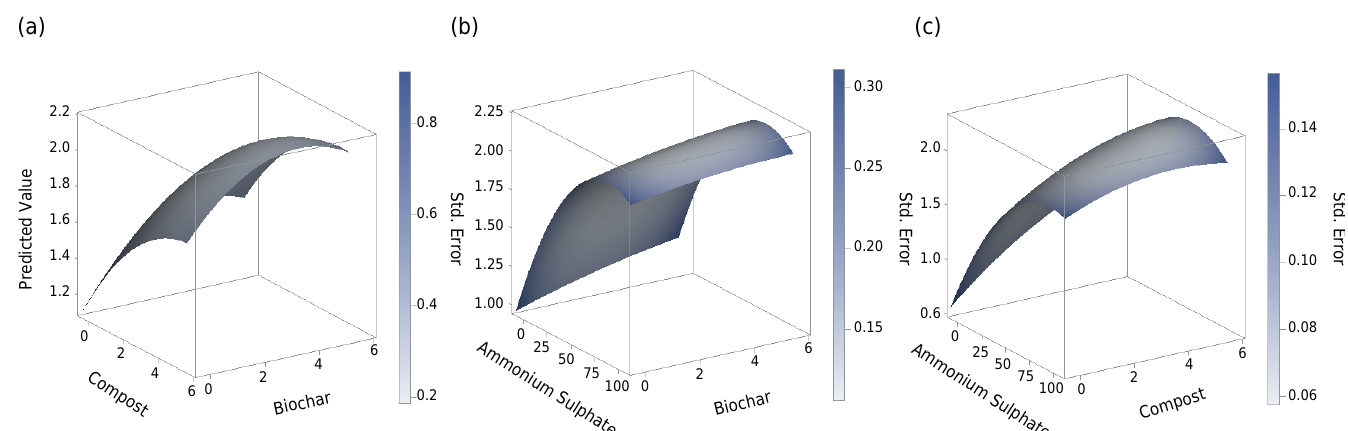
Figure 7. The SY (t ha -1 ) response to independent variable: (a) biochar (t ha -1 ) and compost (t ha -1 ); (b) biochar (t ha -1 ) and ammonium sulphate (kg ha -1 ); (c) compost (t ha -1 ) and ammonium sulphate (kg ha -1 ).